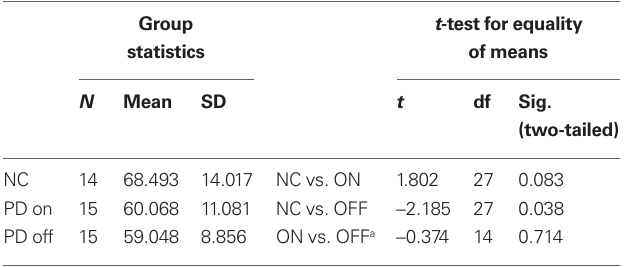
Table 4 | Percentage of correct choices on the instrumental learning task with constant reward contingencies.